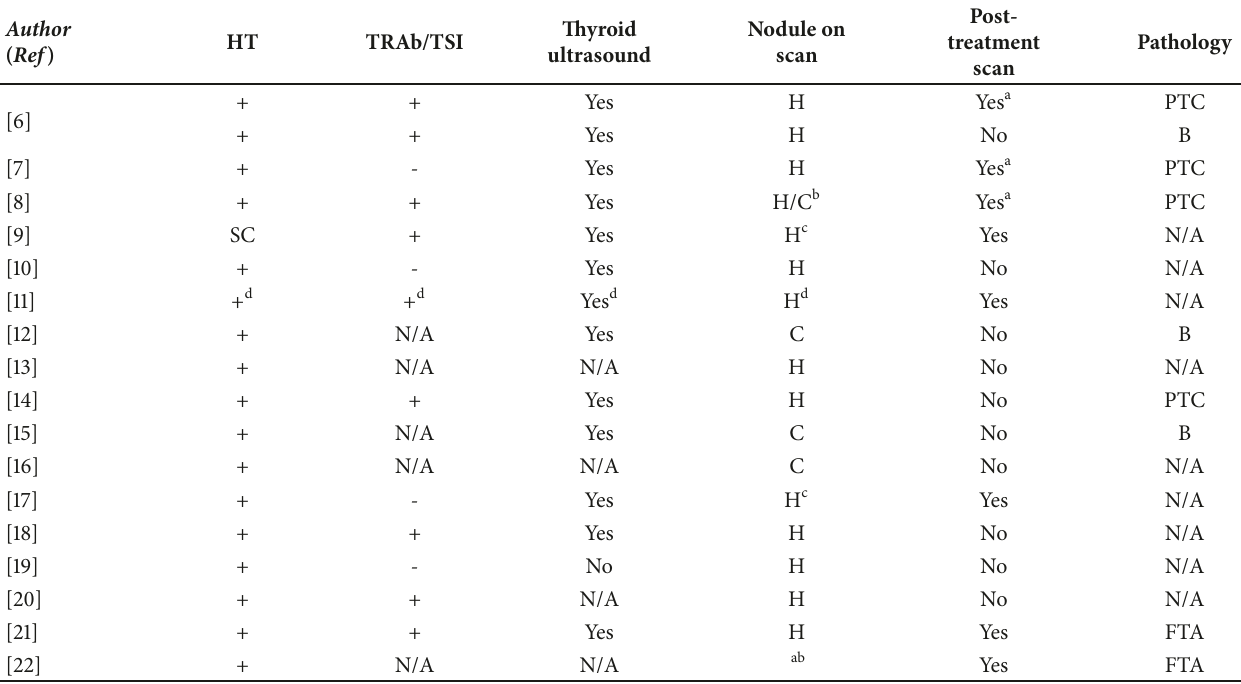
Table 1: Diagnosis of Marine-Lenhart syndrome in the literature: most recent to